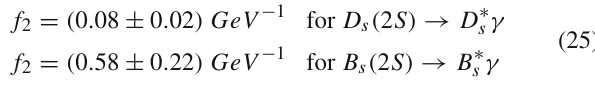
In Figs. 3 and 4 we depict the dependency of the coupling constant f 2 on M 2 at fixed values of s 0 for D s ( 2 S ) → D ∗ γ , respectively. Once we take into and B s ( 2 S ) → B ∗ s